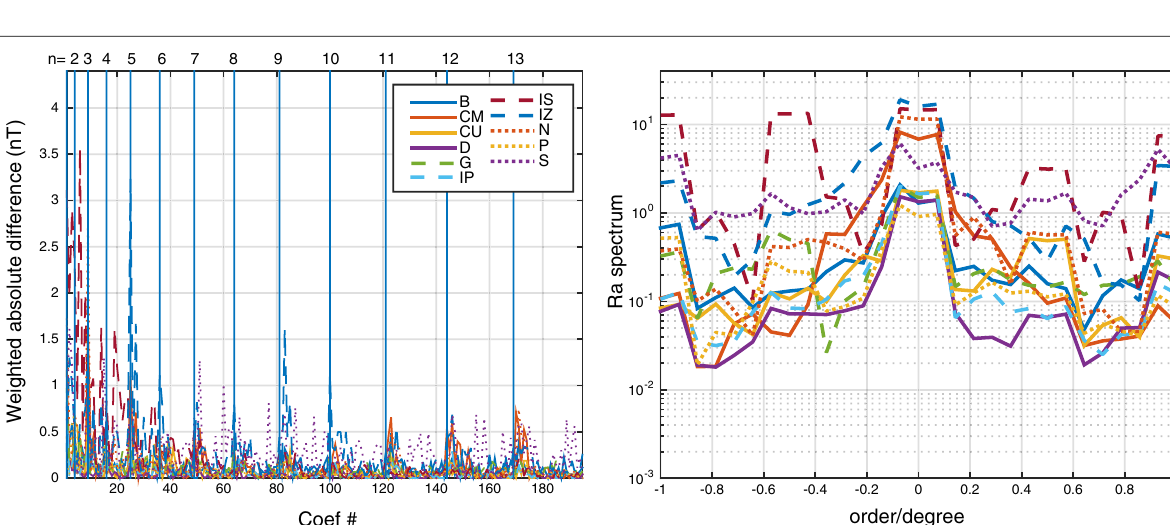
Fig. 2 Absolute Gauss coefficient differences weighted by a factor of √ n DGRF-2015 candidates and the median